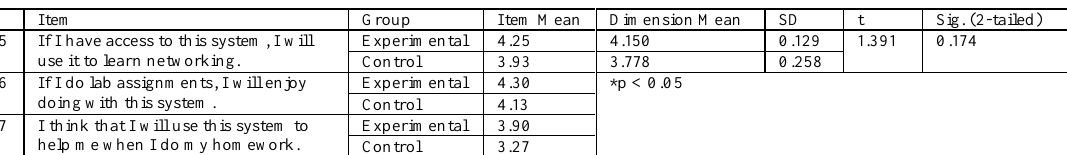
Table 9 Behavioral Intentions when using